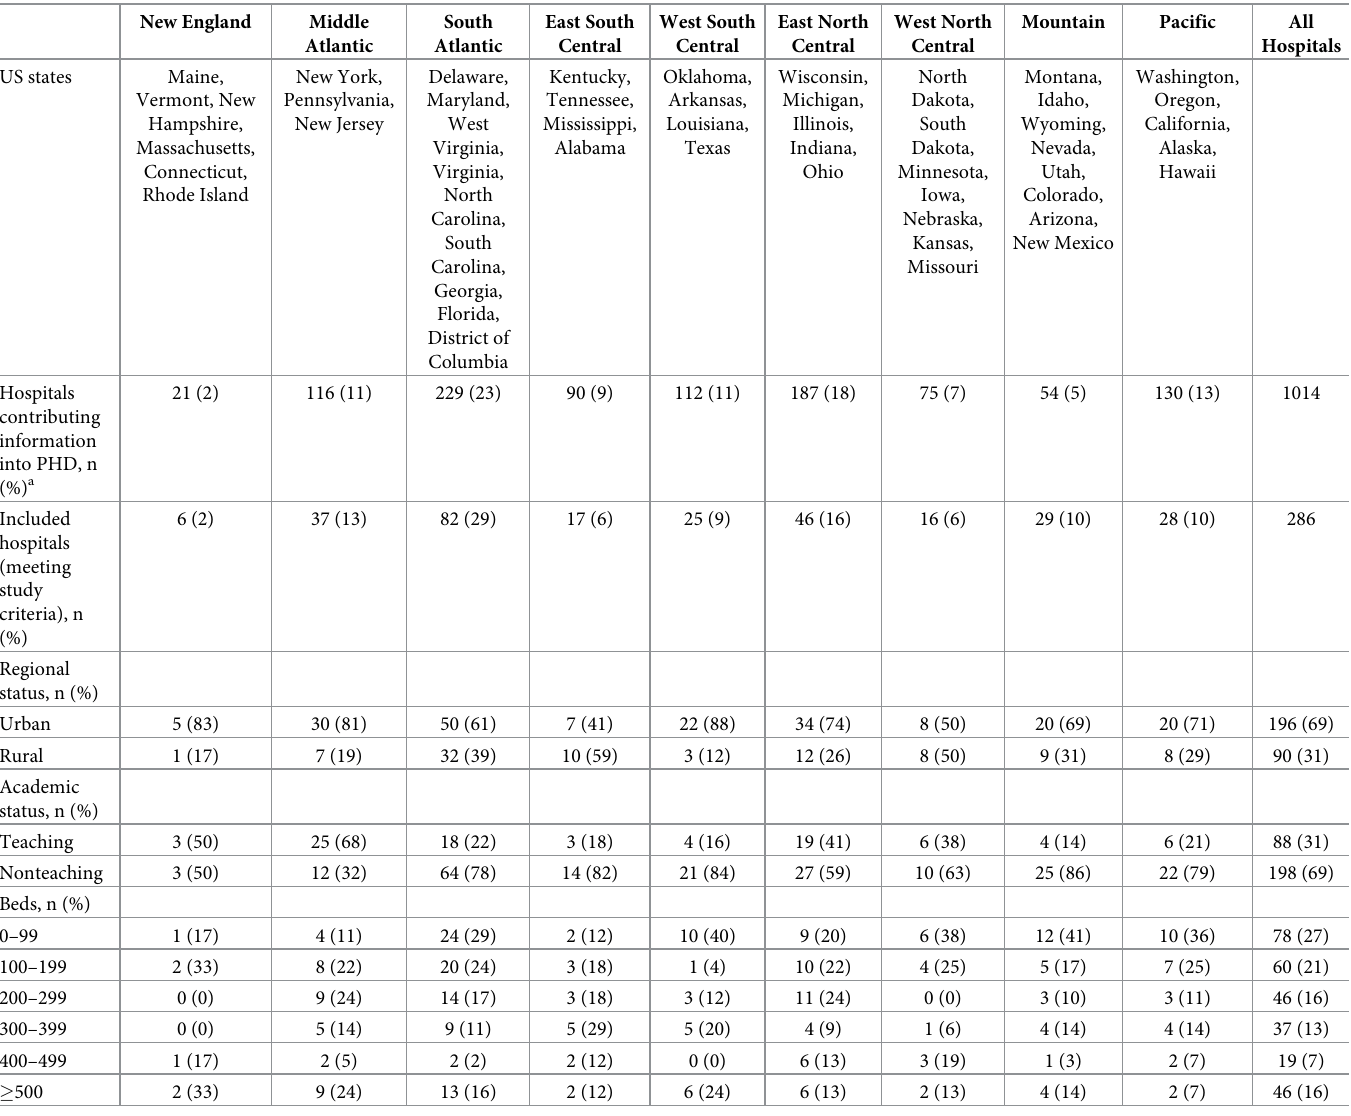
Table 1. Characteristics of study hospitals by Census division, January–July in